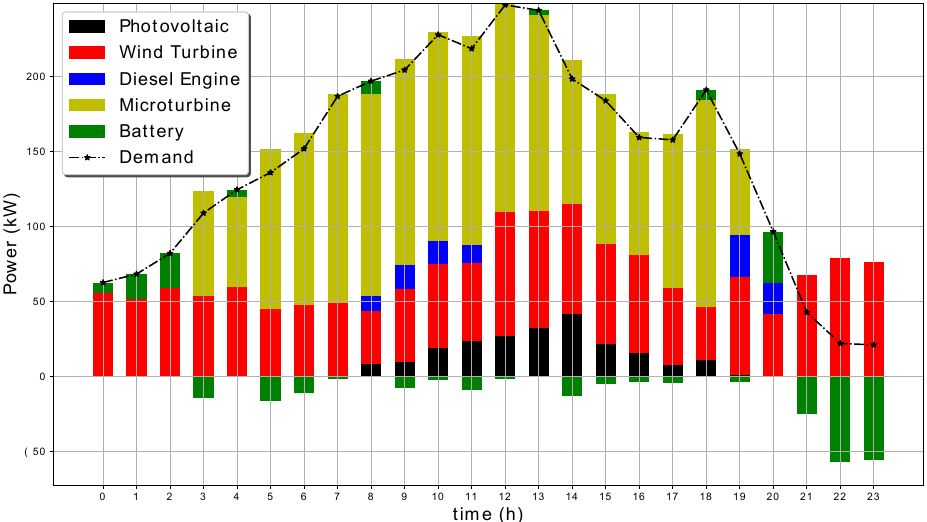
Figure 6. Optimal power scheduling for the time period considered by using offline optimization without taking into consideration uncertainties